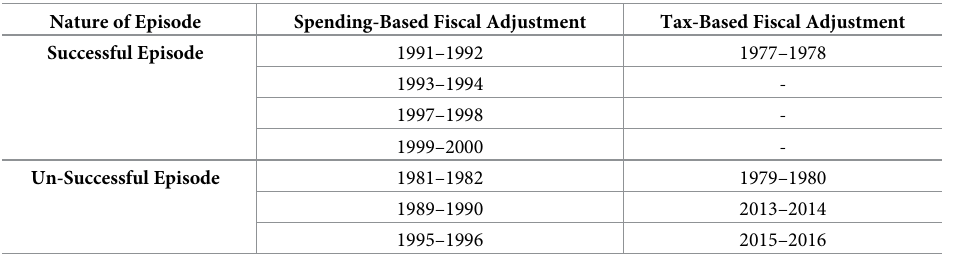
Table 1. Distinction between successful and un-successful